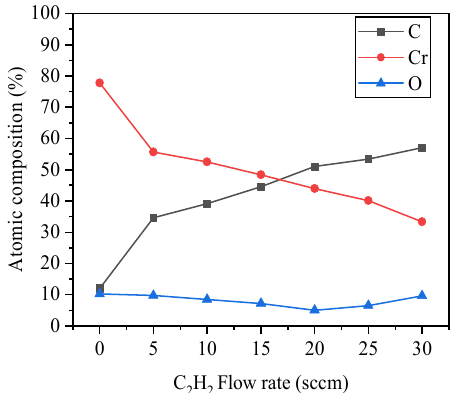
Figure 2. Composition of CrC coatings with increasing C 2 H 2 flow rate.